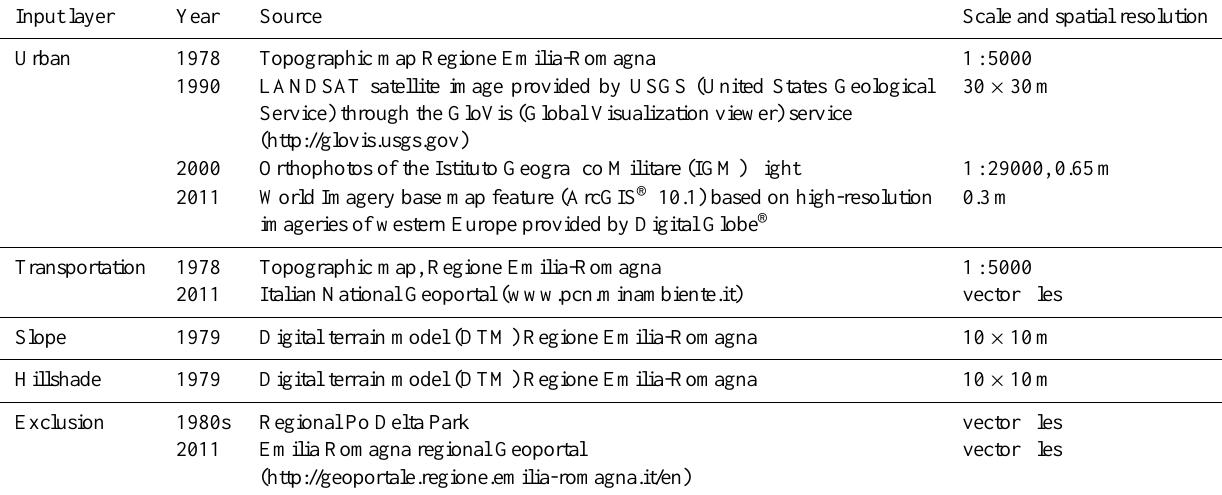
Table 2. Input data layers for